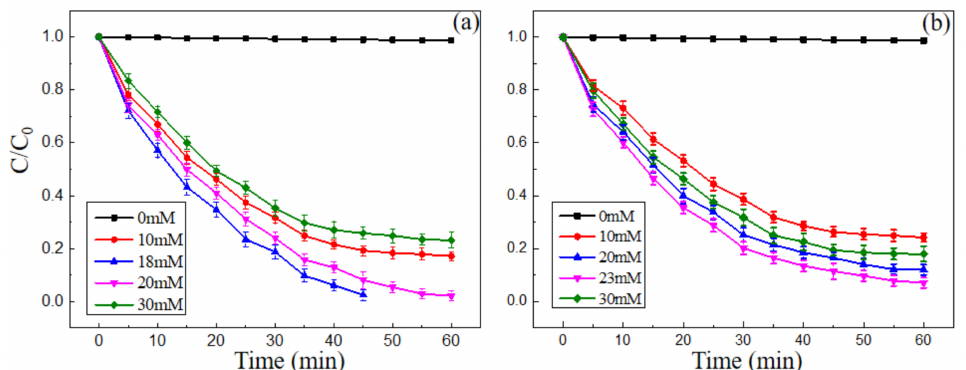
Figure 9. Effect of initial H 2 O 2 concentration on the degradation of ( a ) MB and ( b ) MO solution. Experimental conditions: initial pH value of 3, catalyst synthesized with 8 × 10 − 4 mol/L CuCl 2 solution, 30 ◦